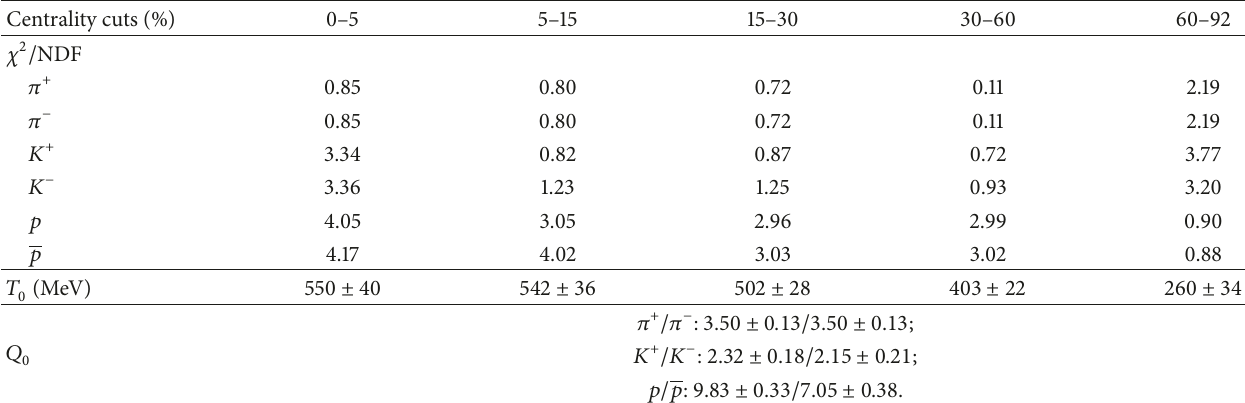
Table 2: The 𝜒 2 / NDF and the fitted initial temperature 𝑇 0 and constant 𝑄 0 at 68.3% confidence level in different centrality Au-Au collisions at √𝑠 NN = 130